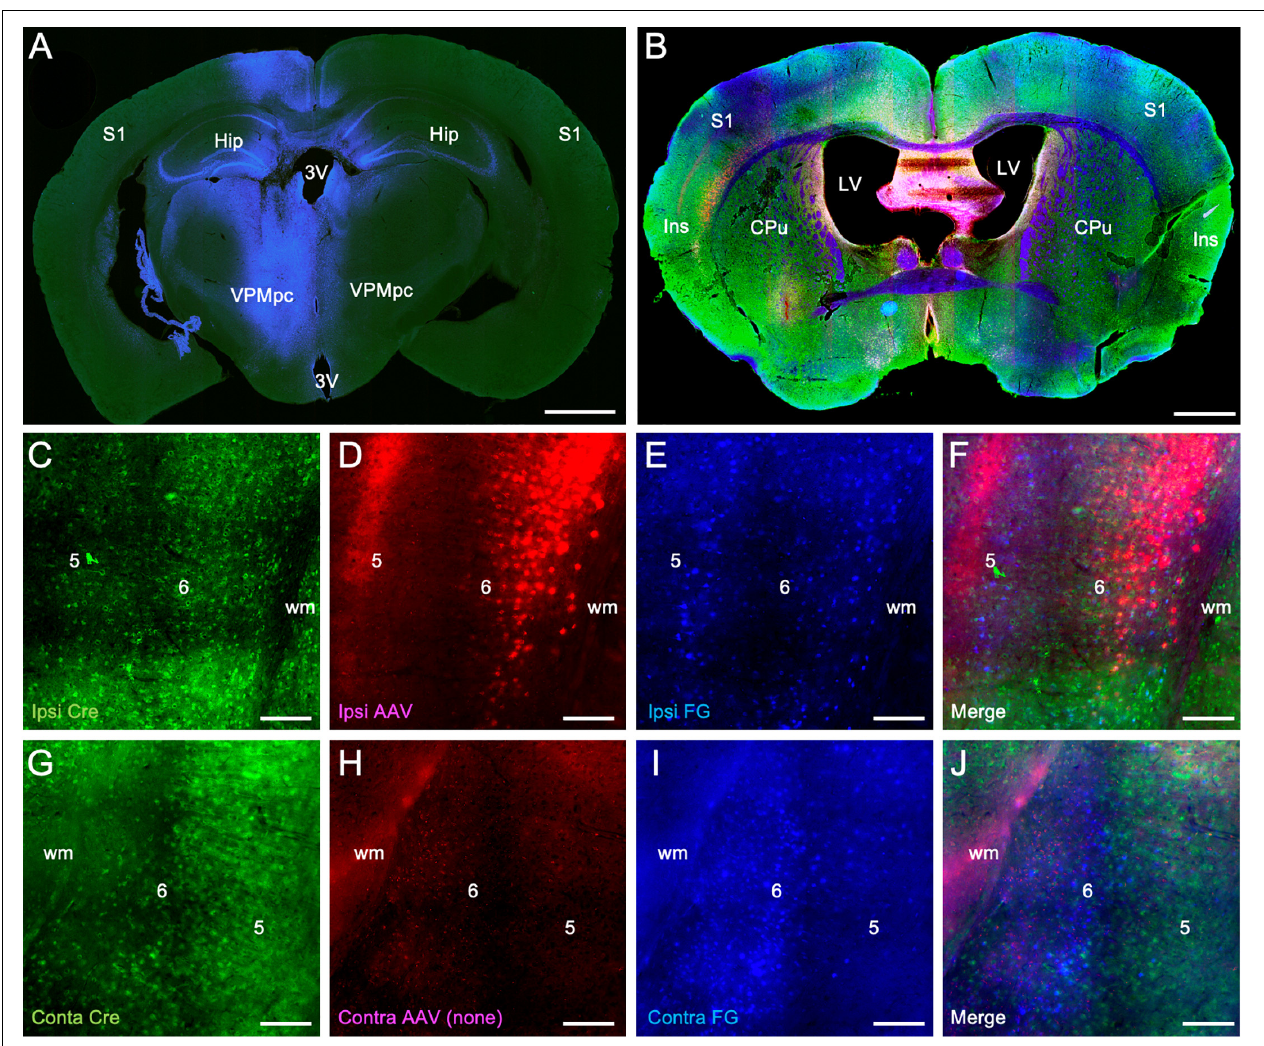
FIGURE 3 | Colocalization of retrograde corticothalamic labeling with Ntsr1-Cre-recombinase positive insular corticothalamic neurons. (A) Injections of fluorogold (blue) were stereotactically centered in the left VPMpc, as in Figure 2 . (B) In the same animal, injection of an AAV vector expressing mCherry (red) was stereotactically targeted to the ipsilateral insular cortex, as in Figure 1 . Retrogradely labeled sections were immunohistochemically stained for Cre-recombinase expression (green). (C–F) Retrogradely labeled corticothalamic neurons (blue) were again observed in layer 6 of the insular cortex. Many retrogradely labeled neurons (blue) were found to colocalize with both Cre-recombinase positive neurons (green) and with neurons expressing mCherry (red) following viral transfection. (G–J) Similarly, in the contralateral insular cortex, retrogradely labeled neurons (blue) were found to colocalize with Cre-recombinase positive neurons (green), although to a lesser extent than that observed in the ipsilateral insular cortex. Abbreviations are the same as in Figure 1 . Scale bars: (A,B) : 1 mm; (C–J) : 100 µ